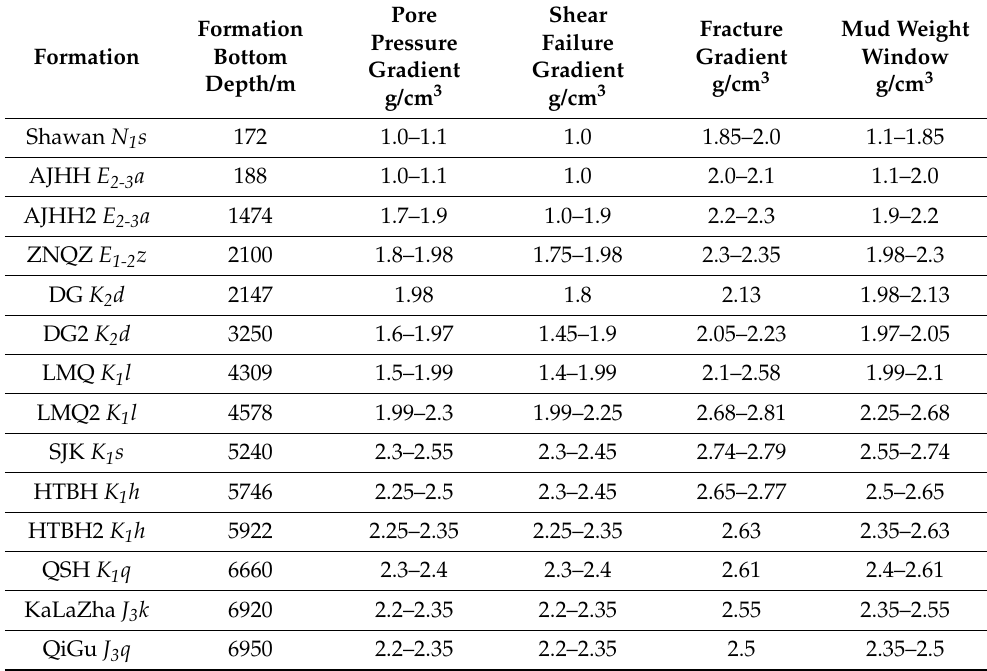
Table 3. Mud weight window prediction for each formation in well